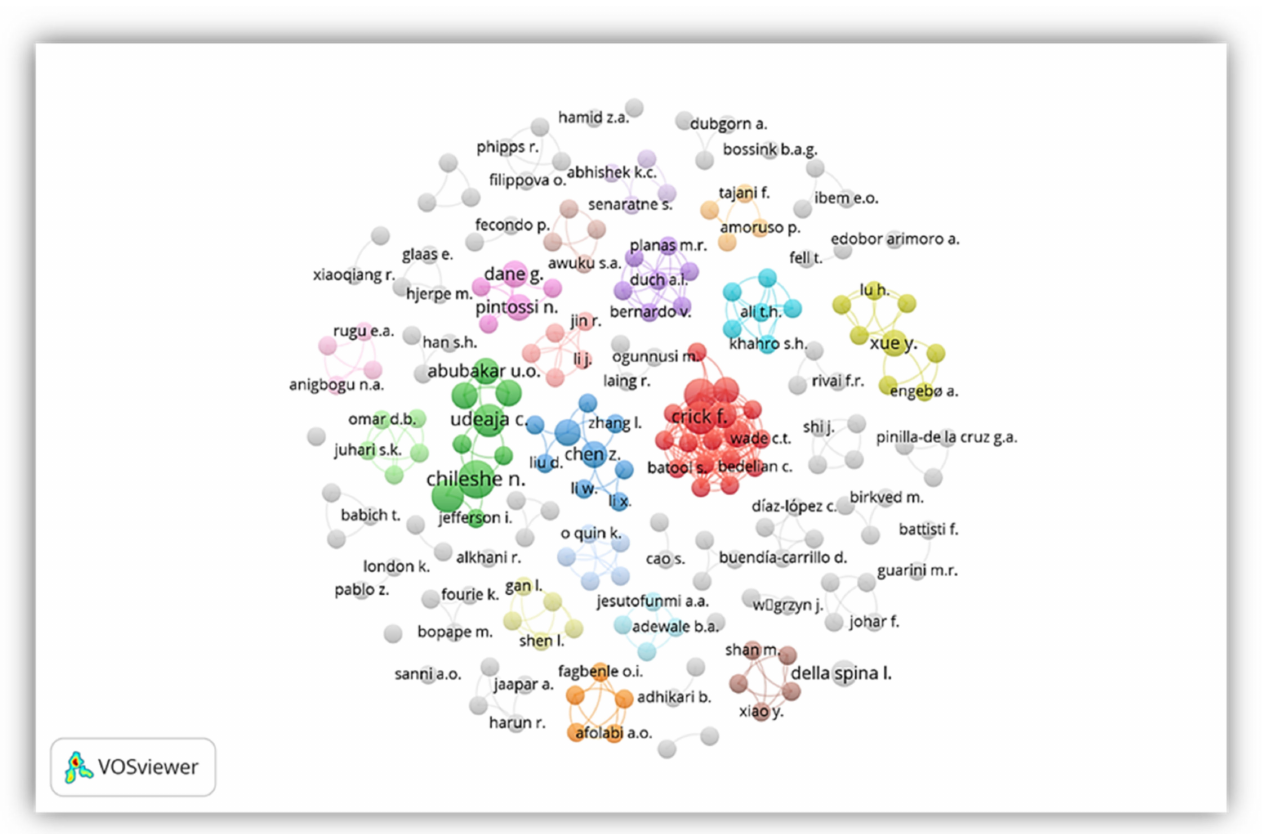
Figure 5. Co-authorship